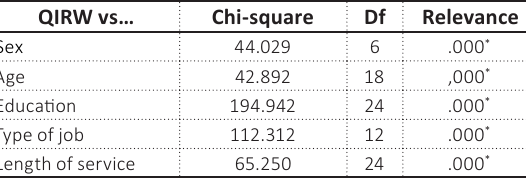
Table 3. Pearson’s chi-square coefficients for the relationship between the quality of interpersonal relationships at work and analyzed demographic variables QIRW vs… Chi-square Df Relevance